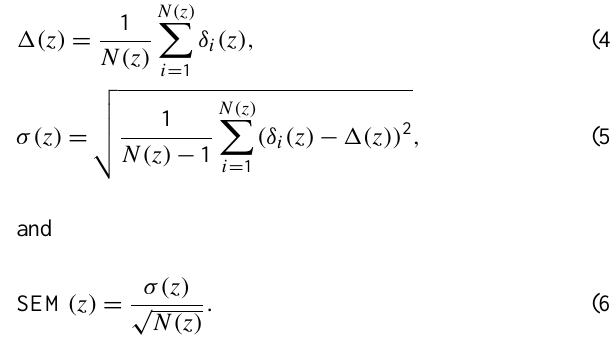
Figure 12. Left panel: mean profiles over all collocations from SCIAMACHY and balloon born data (the two lines show the data interpolated on the retrieval grid of SCIAMACHY and smoothed with the AVK of SCIAMACHY, respectively) and their standard de- viations (dashed line). Right panel: mean percentage difference be- tween SCIAMACHY water vapour profiles and balloon borne pro- files interpolated to the SCIAMACHY retrieval grid (black line) and smoothed with the AVK of SCIAMACHY (green line). The dotted lines show the standard deviation, the error bars (if visible) depict the standard error of the mean. The number of collocations is given for each